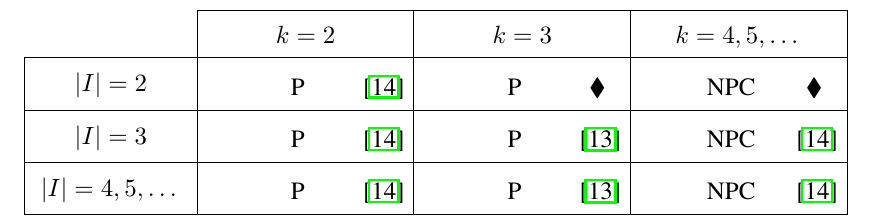
Tab. 2: Complexity of SRCP restricted to particular values of k and | I